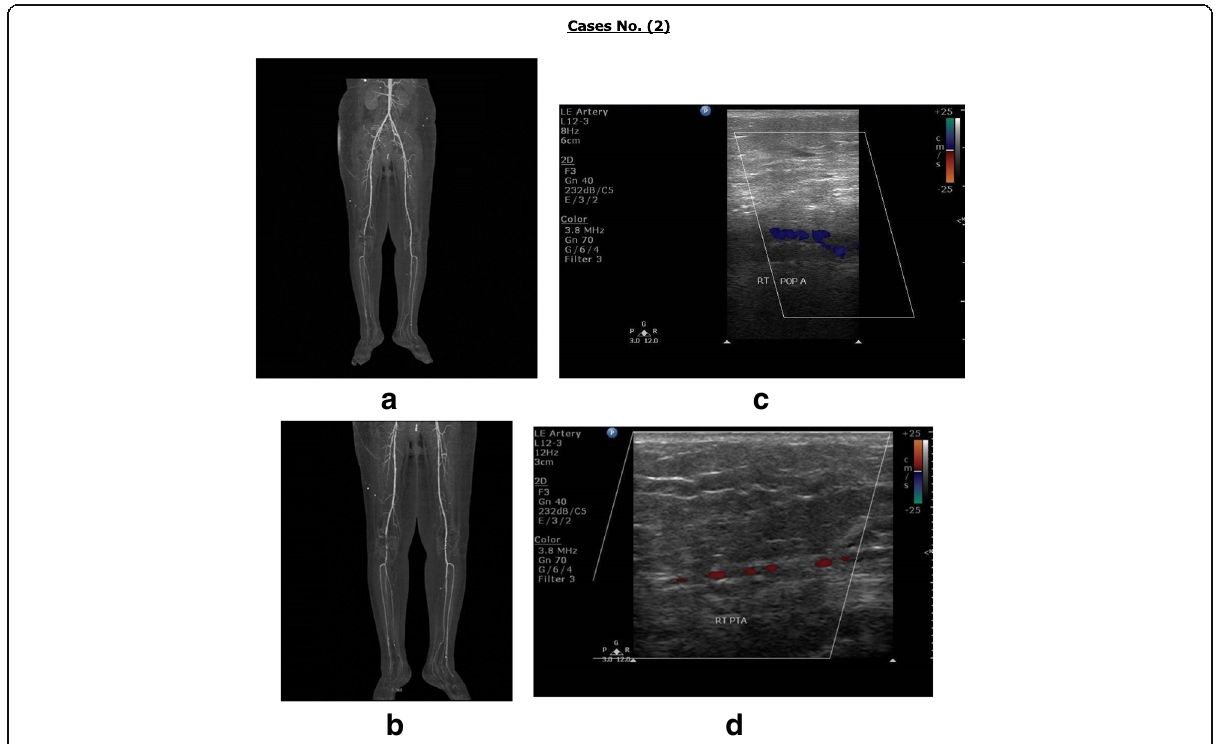
Fig. 2 Female patient aged 49 years, diabetic, not hypertensive, cardiac, or smoker. a Bilateral atherosclerotic changes with attenuated POP A at both sides and occluded segment at the right POP. b Attenuated PTA at both sides and right peroneal artery with non- opacified left one. c Completely occluded RT POP A segment. d Attenuated distal